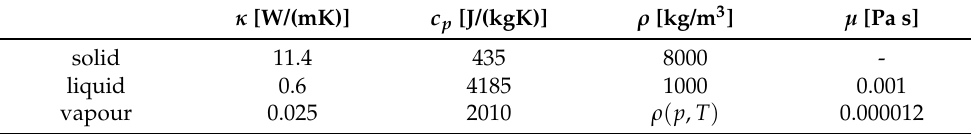
Figure 3. Computational domain with dimensions, boundary conditions names and investigated locations on the sample marked using orange dots. L1—Above the plate centre at the solid–fluid interface; L2—Plate centre; L3—Beneath the plate centre at the solid–fluid interface. Table 5. Physical properties of water, vapour and the plate